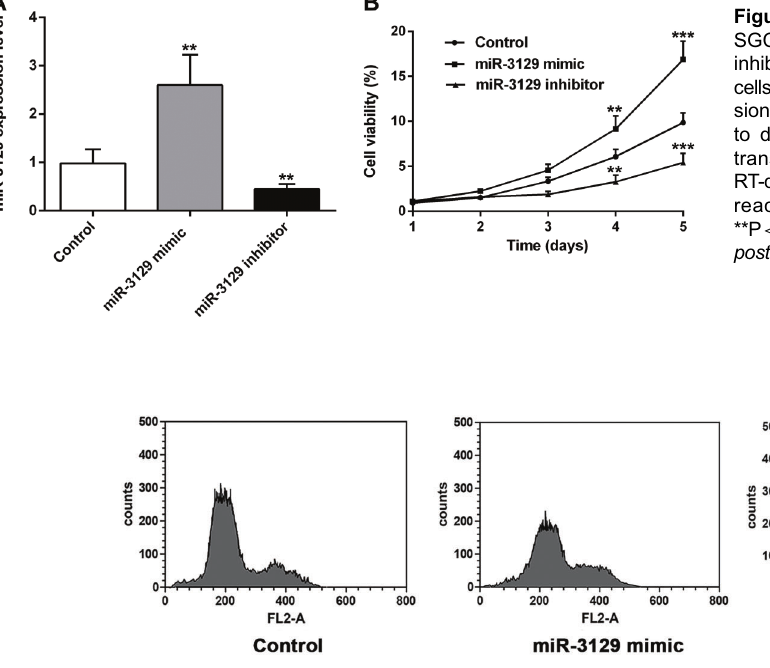
Figure 2. Effect of miR-3129 expression on SGC7901 cells viability. A , miR-3129 mimic and